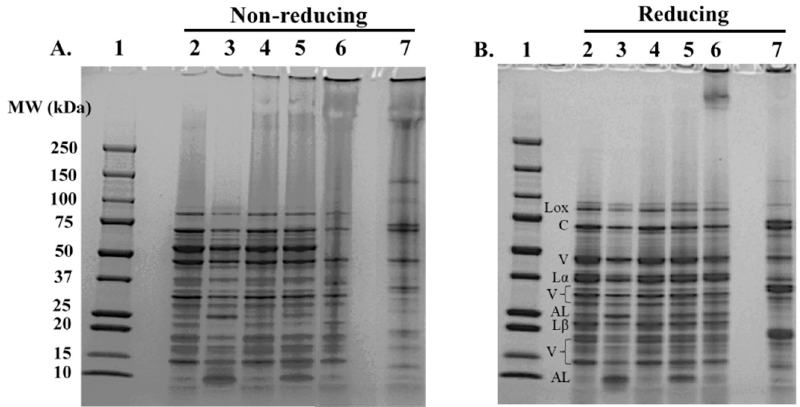
Figure 1. SDS‑PAGE gel visualization of the protein profiles of protein isolate samples under non‑ reducing ( A ) and reducing ( B ) conditions. Lane 1: molecular weight (MW) marker; Lane 2: pH‑PPI; Lane 3: salt‑PPI; Lane 4: SU‑pH PPI; Lane 5: SU‑salt PPI; Lane 6: cPPI; Lane 7: cSPI. Lox: lipoxy‑ genase; C: convicilin; V: vicilin; L α : acidic subunit of legumin; L β : basic subunit of